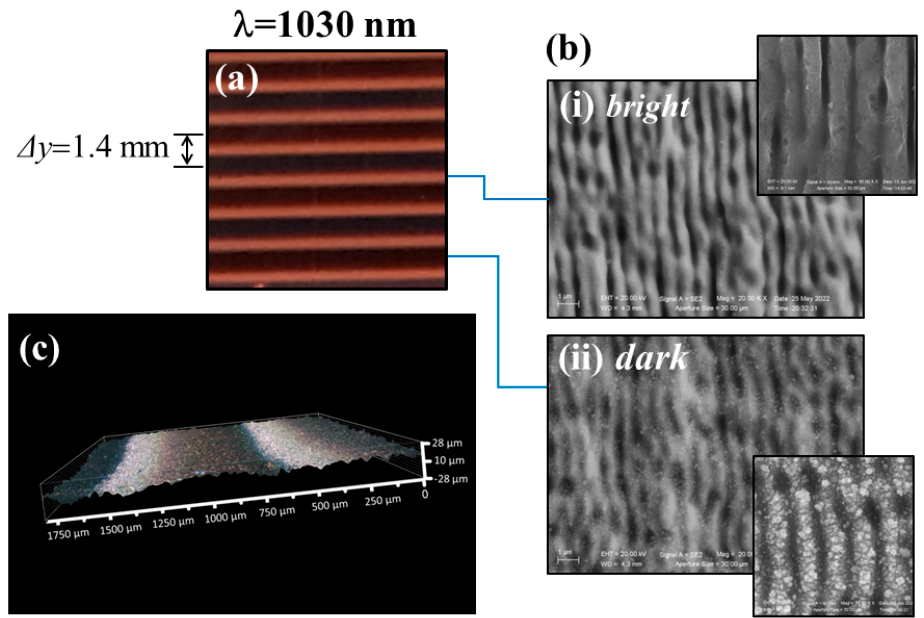
Figure 2. Exemplificative optical and SEM images of the copper sample processed with the cylindrical lens focusing at λ = 1030 nm, with a repetition rate f p = 5 kHz and scanning speed u s = 1 mm/s, a pulse energy E ≈ 10 μ J ( F p ≈ 0.37 J/cm 2 ), and hatch distance Δ y = 1.4 mm. Panel ( a ) displays a photograph of the sample surface evidencing the formation of bright and dark stripes. Panel ( b ) reports SEM images of the corresponding bright and dark bands, respectively. The insets of the SEM images show zoomed views in the two bright and dark regions illustrating the finer morphology of the ripples. Panel ( c ) shows the 3D image of the processed surface.